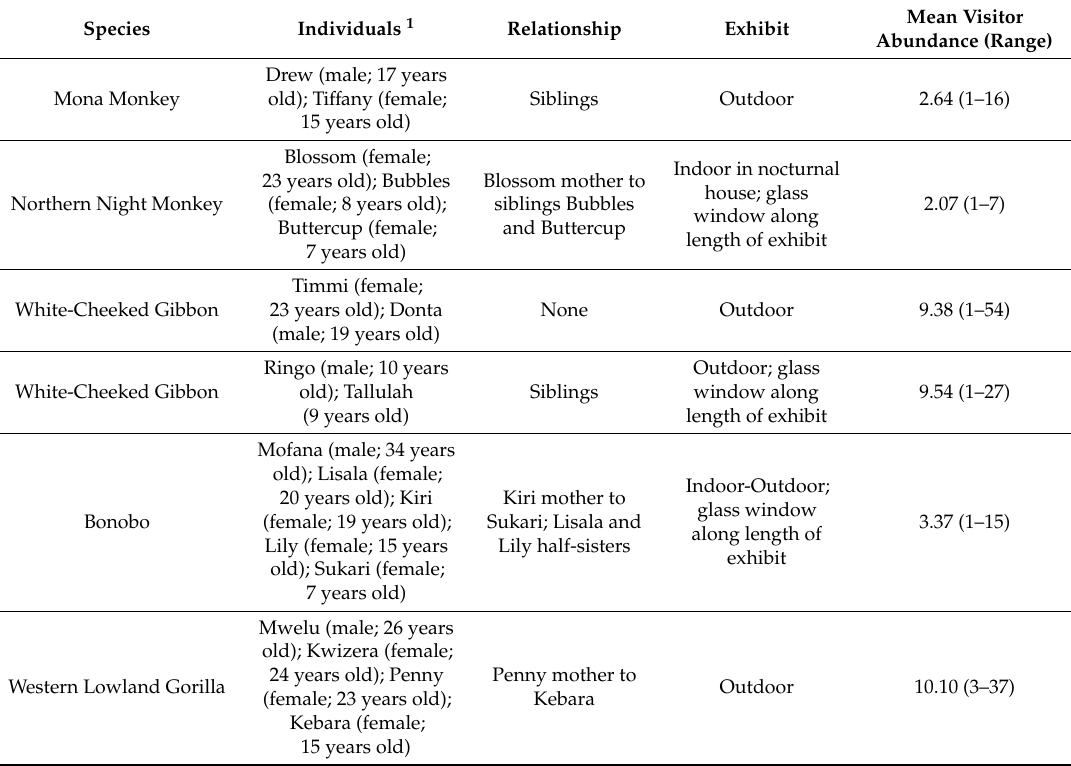
Table A5. Primate species studied for project #5.